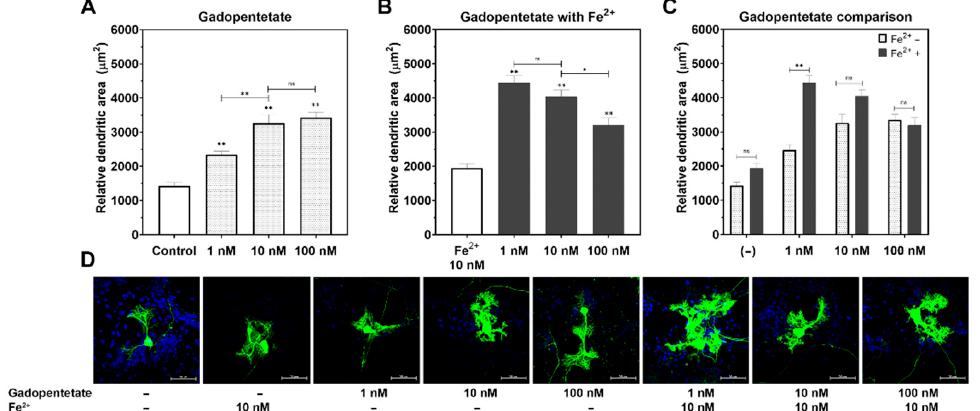
Figure 2. Changes in the relative dendritic area of the Purkinje cells post incubation with gadopente- tate with/without Fe 2+ . ( A ) Gadopentetate significantly increased Purkinje cells’ dendrite arboriza- tion compared to the control group, particularly at 100 nM. ( B ) Fe 2+ attenuated the effect of gadopente- tate on the dendrite arborization. ( C ) The relative dendritic area of Fe 2+ + gadopentetate-treated cells was significantly higher than for gadopentetate-treated cells. ( D ) Representative photomicrograph of gadopentetate-treated Purkinje cells. ** p < 0.01 and * p < 0.05 indicate a statistical significance by Tukey’s HSD post-hoc test compared to the control, unless indicated with a significance bar. ns: not